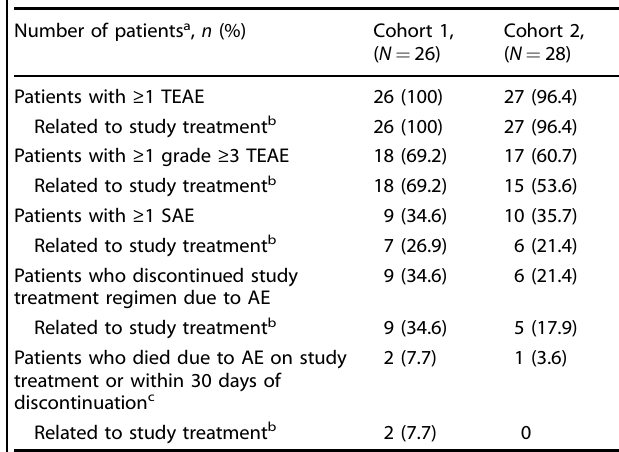
Table 2. Prior anticancer therapy and surgery. Table 3. Safety overview.